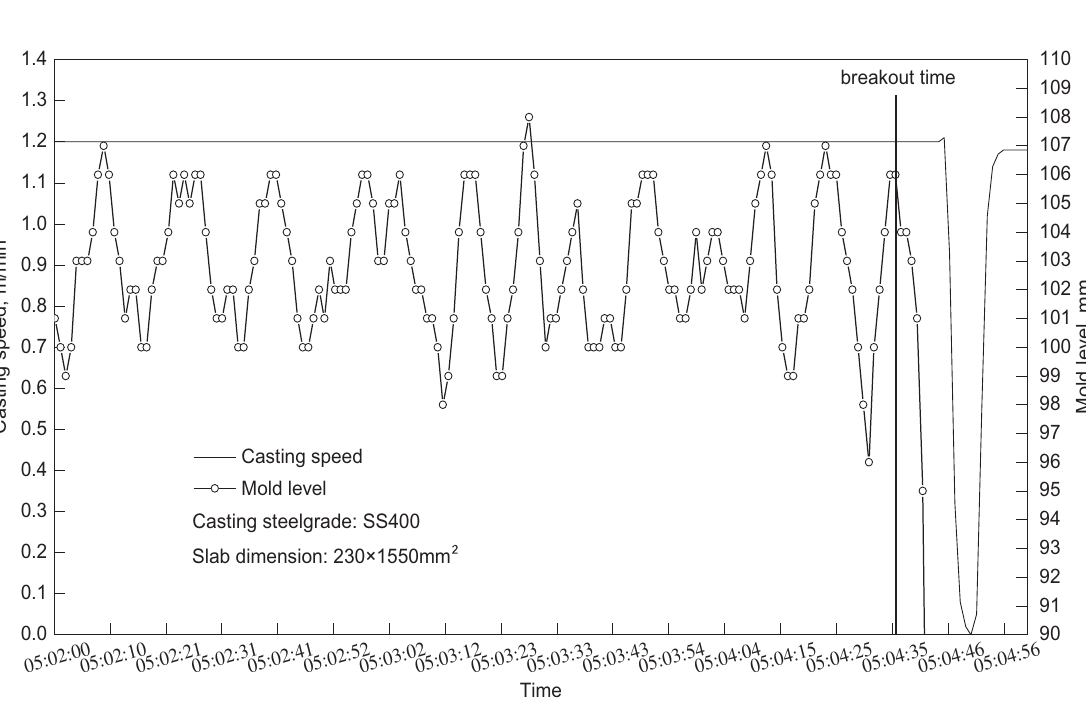
Table 2: Relationship between level fluctuation prior to sticking and number of stickers. Mold level fluctuation prior to sticking, mm